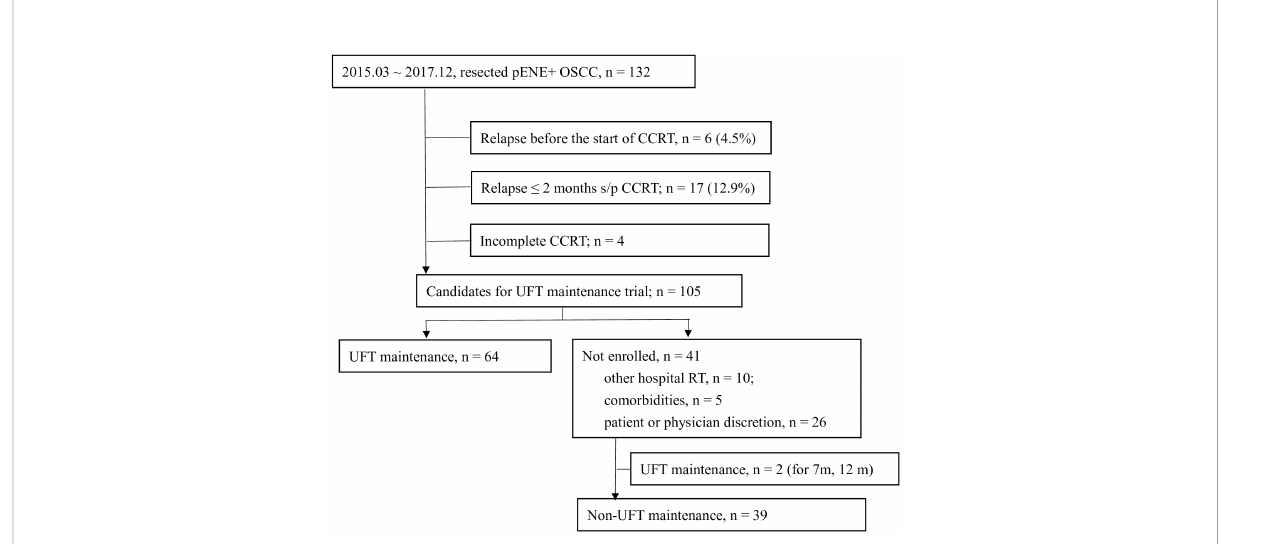
FIGURE 1 Enrollment of patients. pENE , pathologic extranodal extension; OSCC, oral cavity squamous cell carcinoma; CCRT , concurrent chemoradiotherapy; s/p , status post; UFT ,